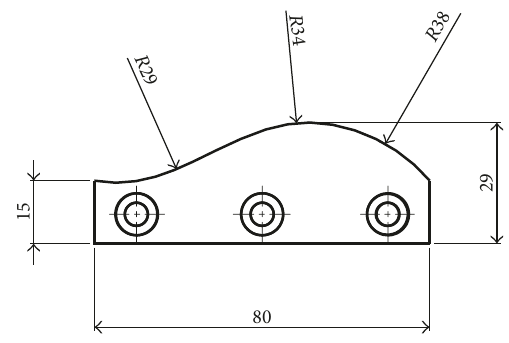
Figure 9: Workpiece (aluminum